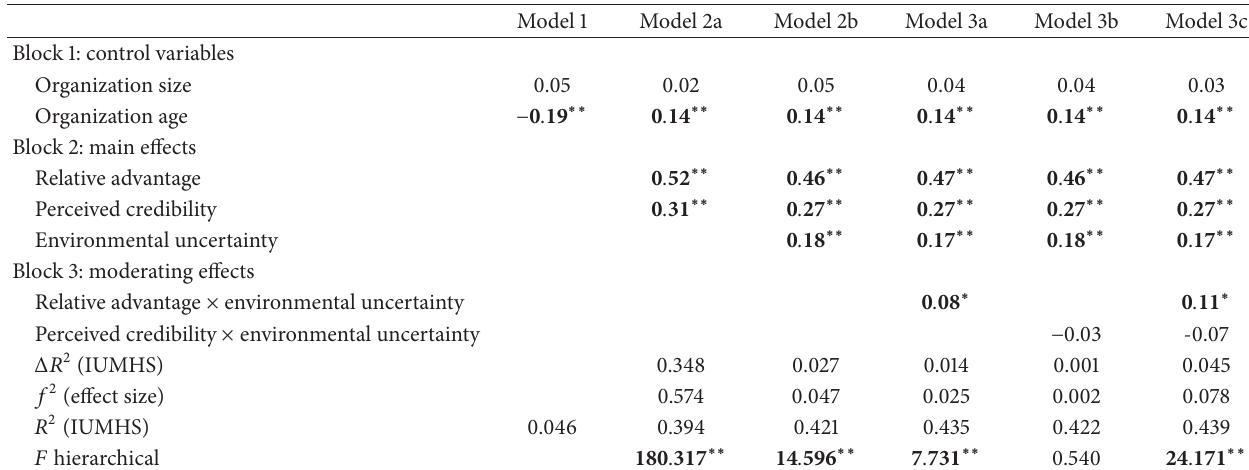
Table 6: Results of hierarchical regression